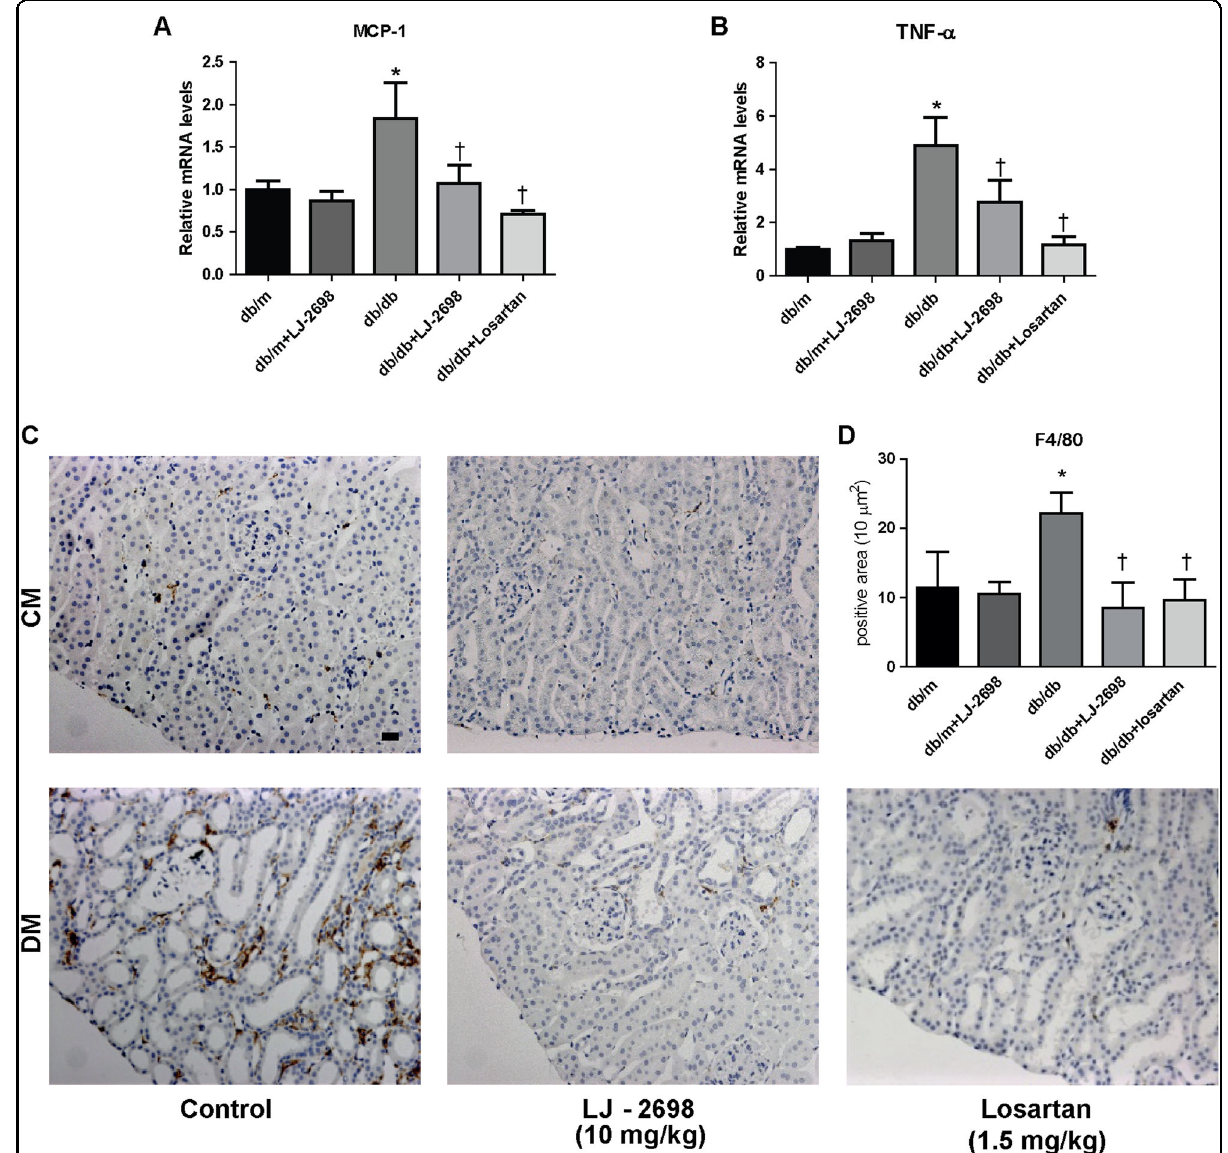
Fig. 6 LJ-2698 ameliorated kidney in fl ammation in db/db mice. After 12 weeks of LJ-2698 administration to db/db mice, mRNA expression of in fl ammatory cytokines in the kidney tissue was measured. ( a ) MCP-1 and ( b ) TNF- α mRNA expression was analyzed by qRT-PCR. Paraf fi n-embedded kidney sections were stained with ( c ) F4/80 antibody. The scale bar indicates 20 μ m; the original magni fi cation was ×200. Quantitative analysis of ( d ) F4/80 positive stained area is depicted. CM control mice; DM db/db diabetic mice. Data are presented as the mean ± SE of 7 – 10 mice/group. * p < 0.05 vs. db/m and † p < 0.05 vs. db/db